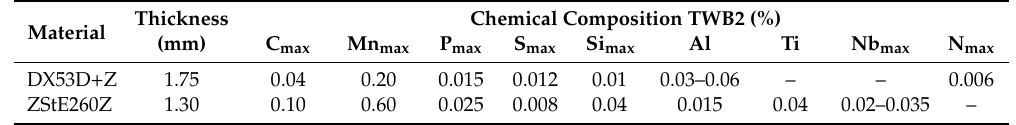
Table 2. Chemical composition and thickness of TWB2.